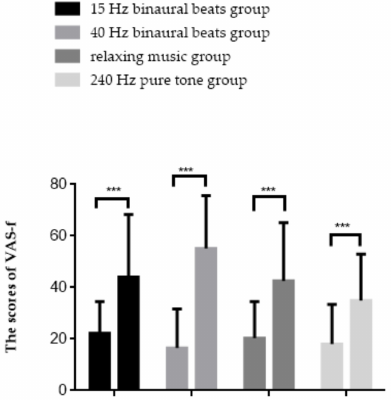
Figure 4. Results of the VAS-f. *** p <